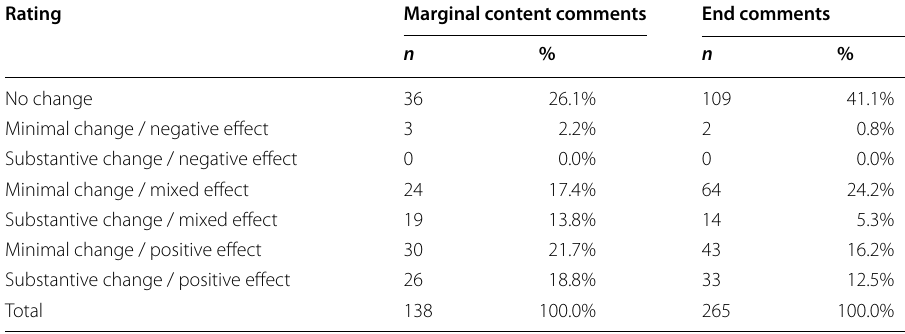
Table 3 Ratings of content and form-focused end comment